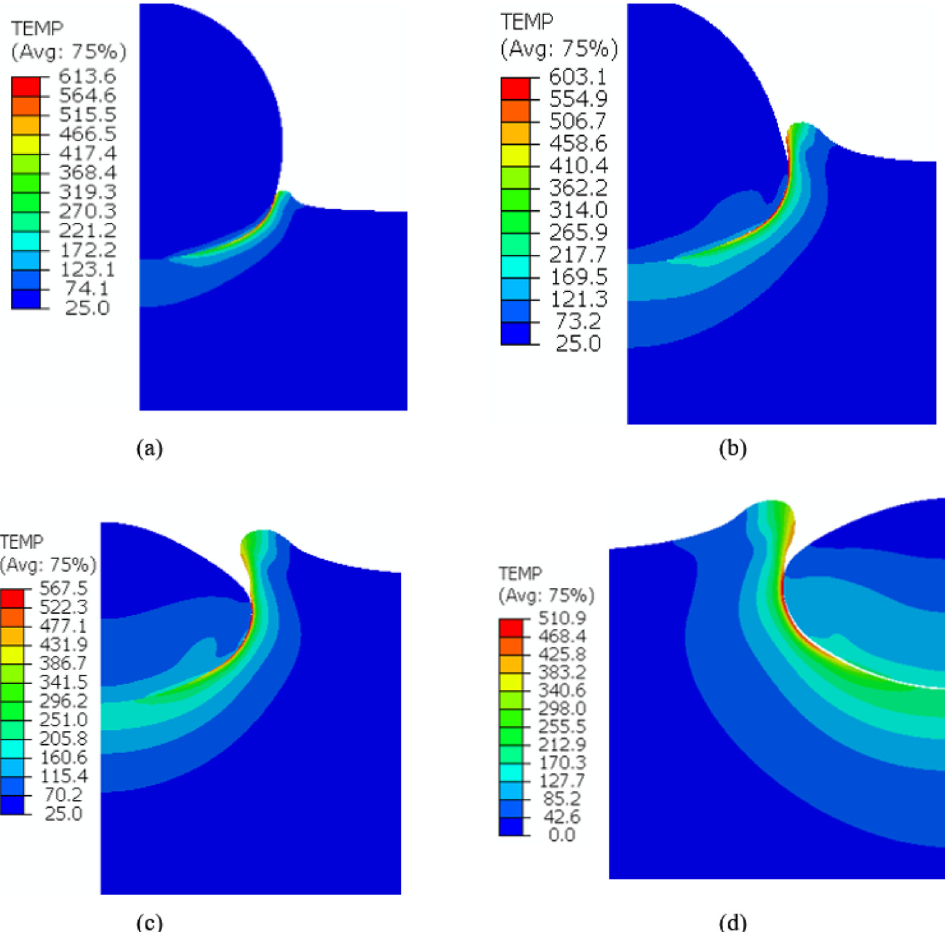
Fig. 8. The time evolution of temperature at 500m/s Cu/Al impact of (a) 5ns (b) 10ns (c) 20 ns (d) 30ns by using the ALE numerical modelling.